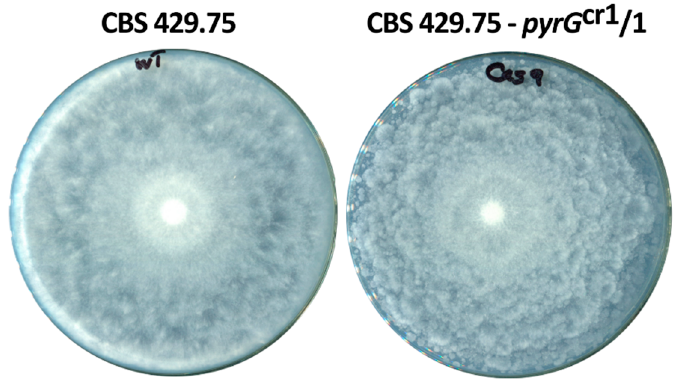
Figure 4. Colony morphology of the original CBS 429.75 and one of the mutants (CBS 429.75– pyrG cr1 / 1) growing on YNB plates at 37 °C.